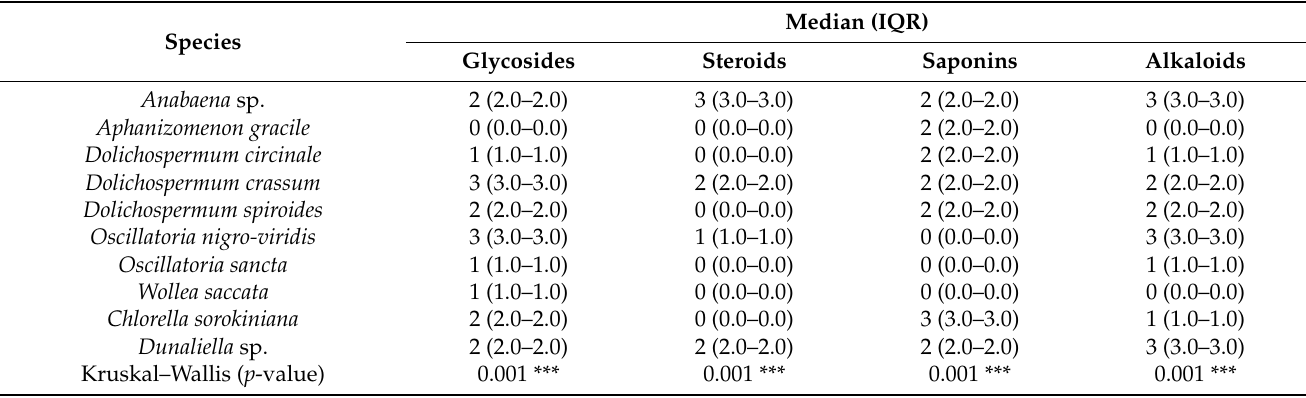
Table 2. Distribution of glycosides, steroids, saponins, and alkaloids among the different cyanobacte- rial and algal strains studied. Differences were assessed using the Kruskal–Wallis test.